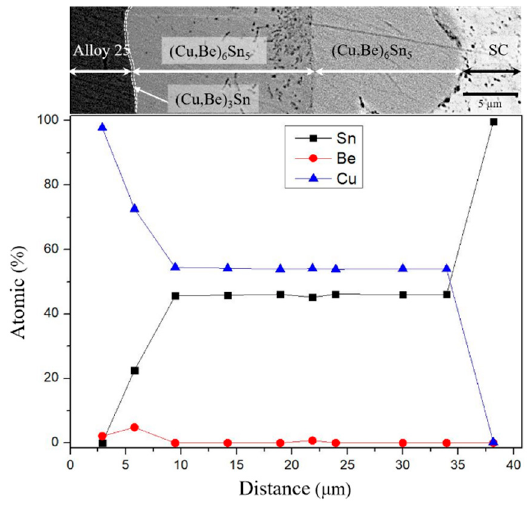
Figure 4. BEI micrographs of the SC/Alloy 25 reaction couples at 240 °C for ( a ) 0.5 h, ( b ) 1 h, ( c ) 4 h, and ( d ) 10 h; reacted at 255 °C for ( e ) 0.5 h, ( f ) 1 h, ( g ) 4 h, and ( h ) 10 h; and reacted at 270 °C for ( i ) 0.5 h, ( j ) 1 h, ( k ) 4 h, and ( l ) 10 h. ( i ) 0.5 h, ( j ) 1 h, ( k ) 4 h, and ( l ) 10 h.